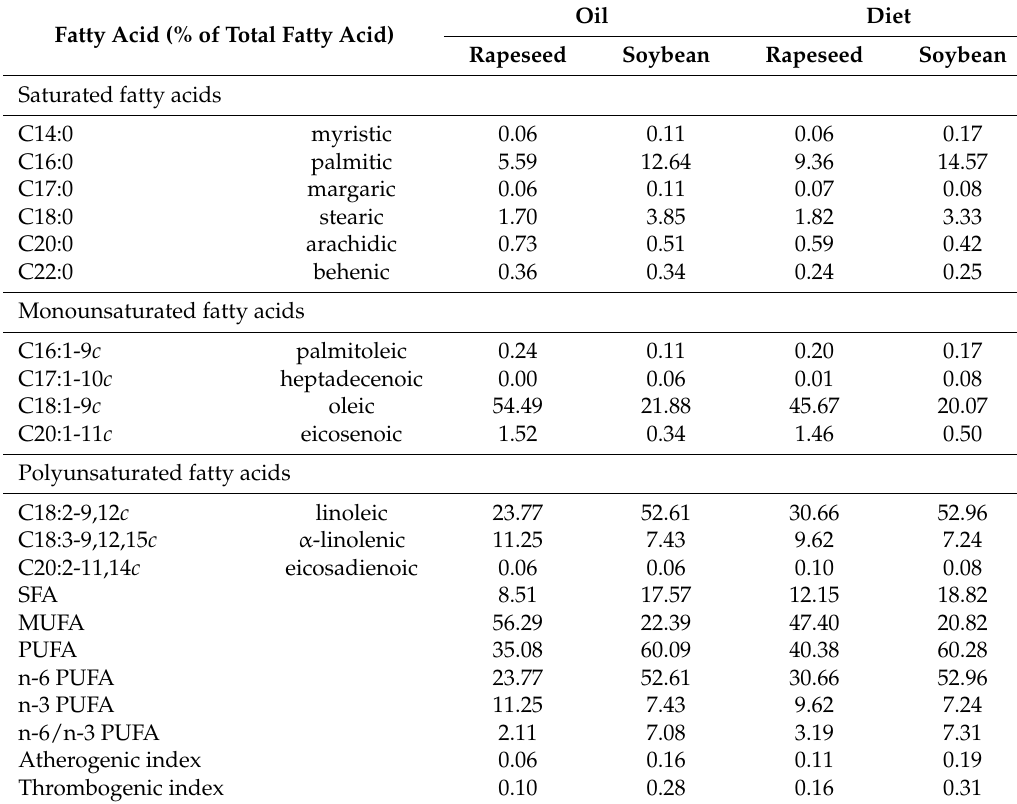
Table 2. Fatty acid composition and ratios of oil and diet